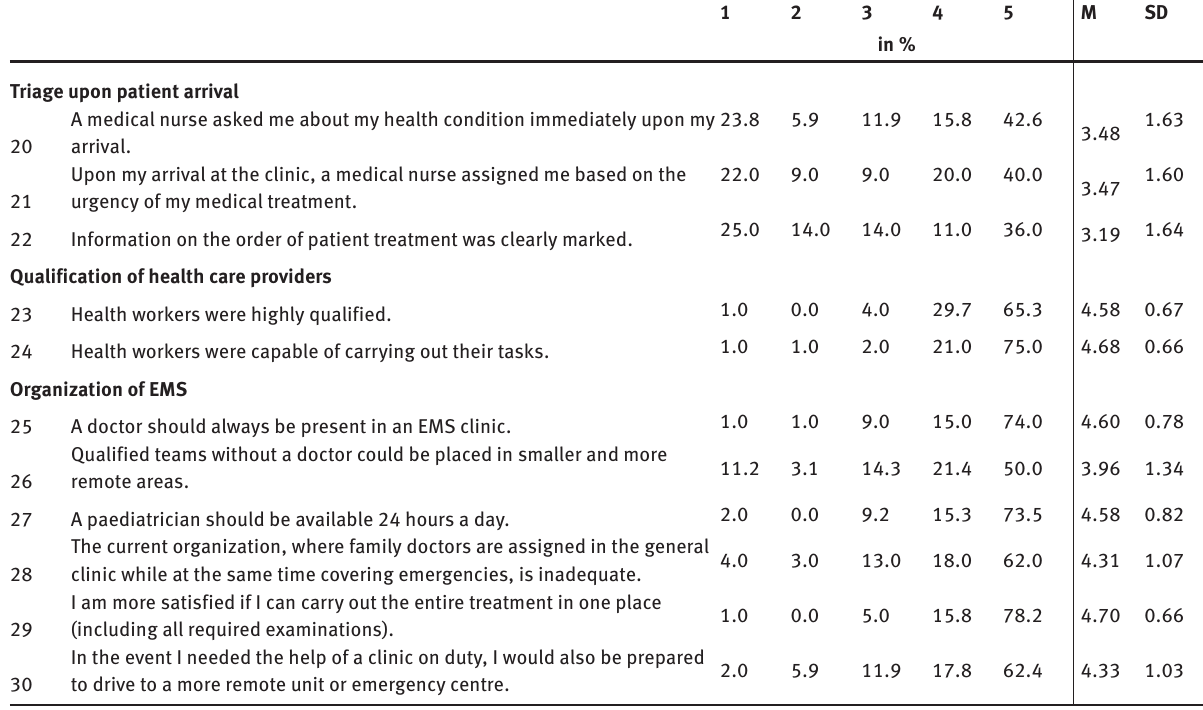
Table 2: Patient view on questions of an organizational nature (legend: M – median value, SD – standard deviation)